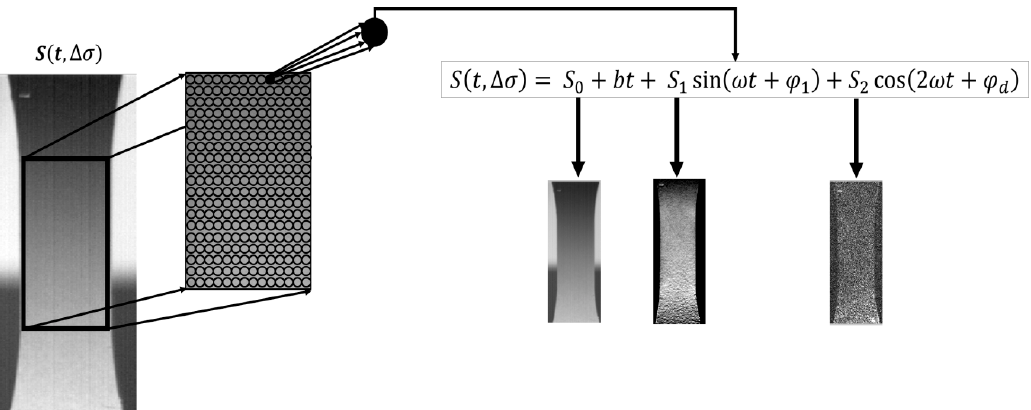
Figure 6. Processing procedure: temperature signal variation outputs.